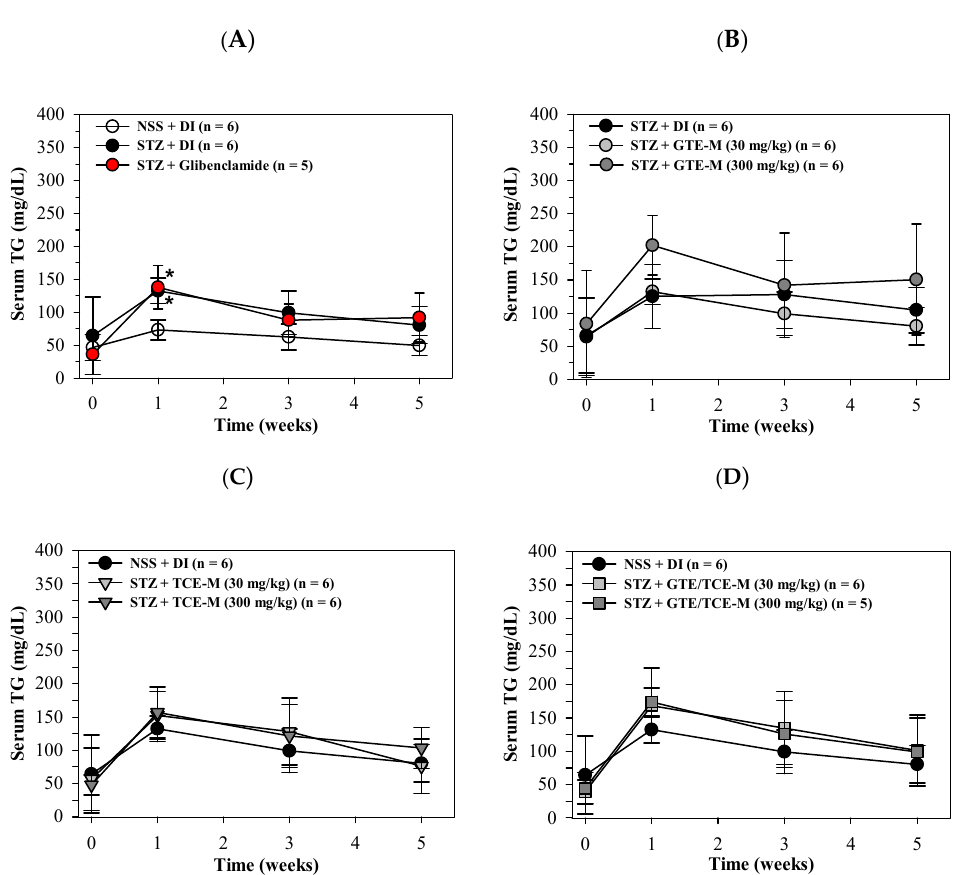
Figure 3. Serum levels of triglyceride in STZ-induced rats intervened with macaroni products. Wistar rats were intraperitoneally injected with STZ (65 mg/kg, single dose) to induce diabetic mellitus or NSS (control) and orally administered with DI, glibenclamide (5 mg/kg) ( A ), GTE-M ( B ), TCE-M ( C ) or GTE/TCE-M ( D ) macaroni products (30 and 300 mg/kg each) every day for four weeks. Data are expressed as mean ± SD values. Accordingly, * p < 0.05 when compared with NSS + DI at the same time. Abbreviations: DI = deionized water, GTE-M = green tea extract-fortified macaroni, GTE/TCE-M = green tea extract and turmeric curcumin extract-fortified macaroni, NSS = normal saline solution, STZ = streptozotocin, TCE-M = turmeric curcumin extract-fortified macaroni and TG = triglyceride.